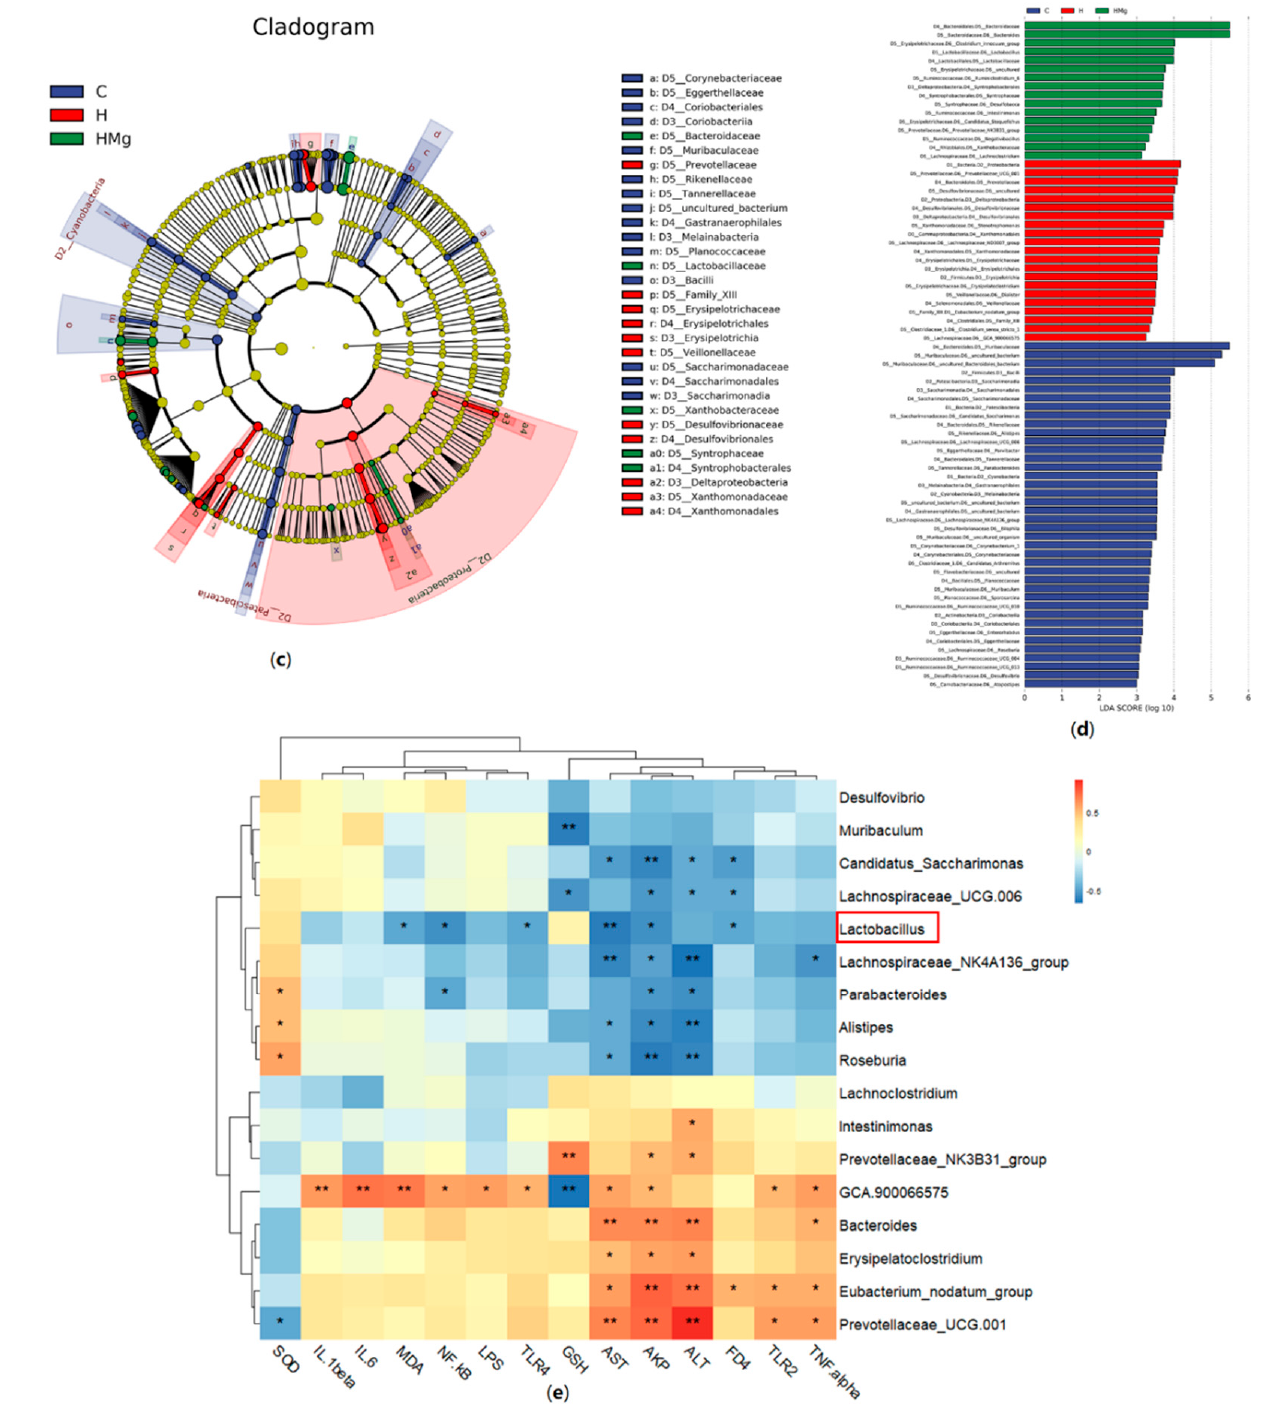
Figure 3. MgIG modifies HRZE-induced gut microbiota composition. ( a , b ) Species composition analysis at the genus level. Compared with the control group: * p < 0.05, ** p < 0.01, and *** p < 0.001, **** p < 0.0001. Compared with the HRZE group. The Line Discriminant Analysis (LDA) Effect Size (LEfSe) analysis. ( c ) Cladogram and ( d ) LDA value distribution histogram ( p < 0.05, LDA > 3). Lactobacillus was the only probiotic that was down-regulated by HRZE and recovered by MgIG. ( e ) Spearman’s correlation analysis heatmap at the genus level (* p < 0.05 and ** p < 0.01). The data are presented as the means ± SEM ( n = 6). Abbreviations: C, control group; H, HRZE group; HMg, HRZE + MgIG